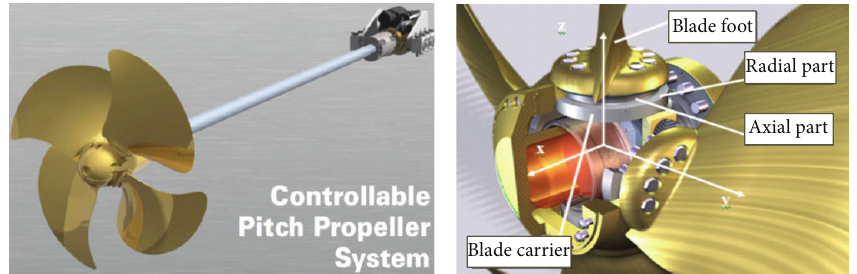
Figure 1: CPP configuration and its coordinate system [8].